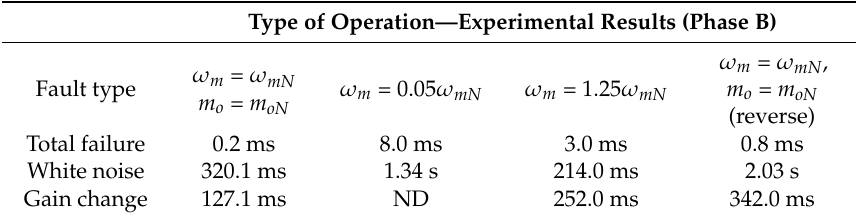
Table 3. Detection times Δ t (ms) of the current sensor fault in the phase B for the NN fault detector (Direct Field Oriented Control structure) from the experimental tests.